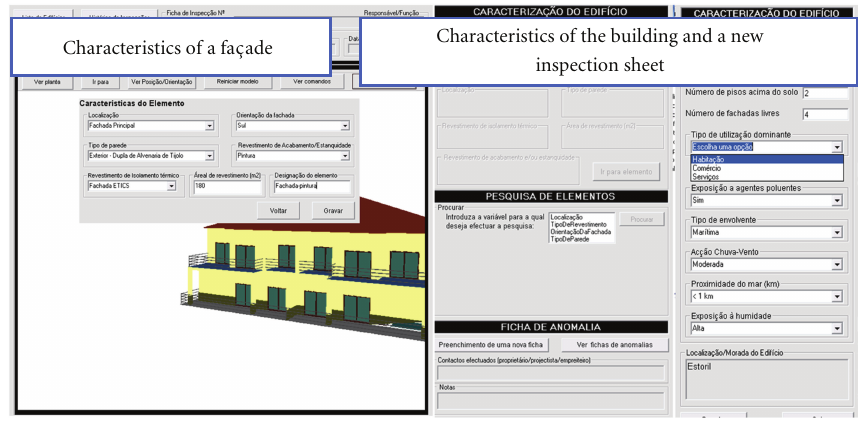
Figure 10: The main interface of the interactive application.